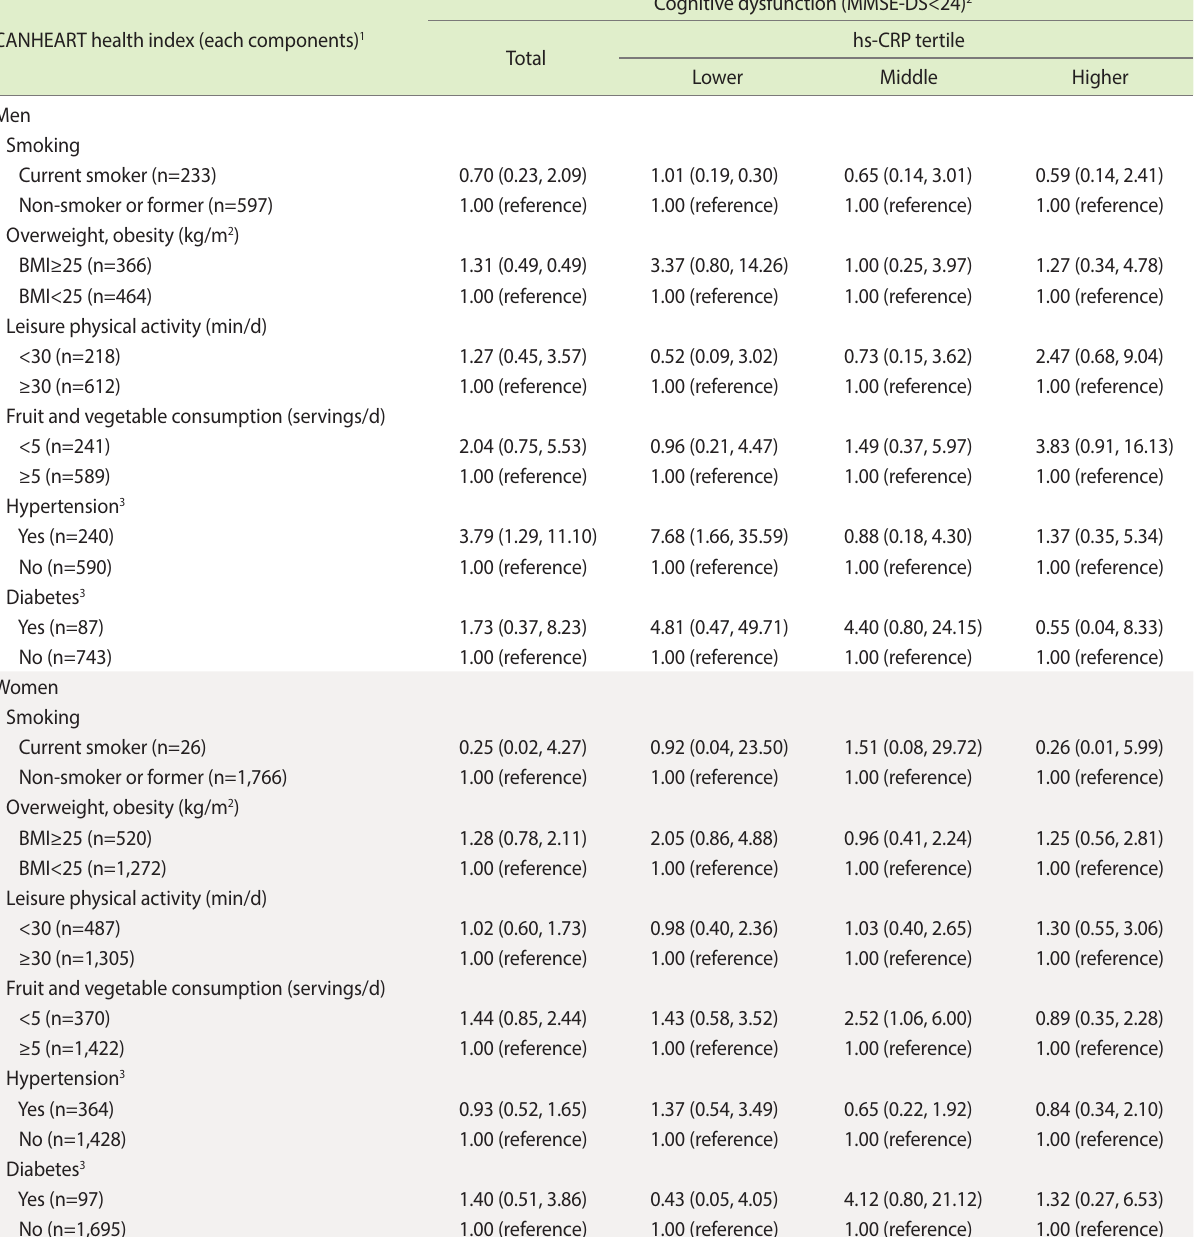
Table 4. Associations between each CANHEART health index component and cognitive function in men and women by hs-CRP tertiles (n=830) CANHEART health index (each components) 1